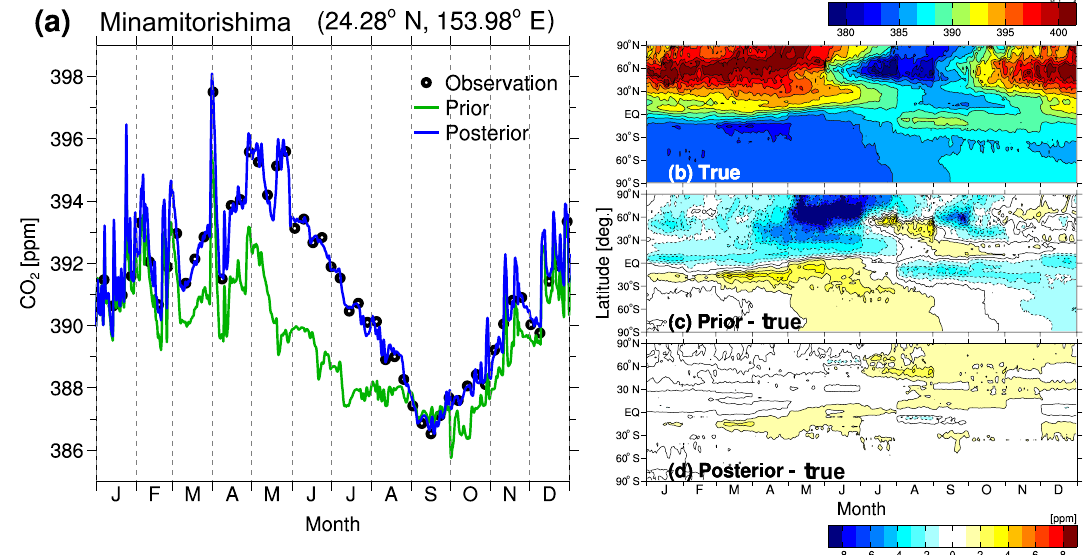
Figure 6. Atmospheric CO 2 concentrations simulated by the forward NICAM-TM driven by the true, prior, and posterior fluxes. The left panel shows the time series of concentrations at the Minamitorishima observational site located in the western North Pacific. Black open circles denote pseudo-observations that are assimilated in the experiment, and green and blue lines represent CO 2 concentrations calculated from the prior and posterior fluxes, respectively. The right panel shows latitude–time cross sections of surface zonal averages calculated from the true flux (b) , its differences from the concentration field generated by the prior flux (c) and by the posterior flux (d) .